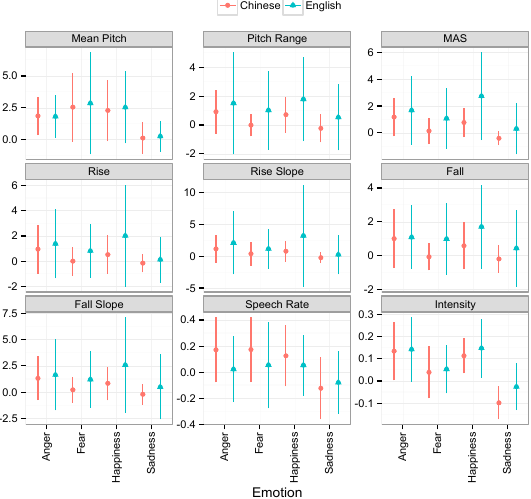
Figure 3. Prosodic cues of four emotions in Mandarin and English. Points indicate mean values and error bars 95% confidence intervals (Adapted from Figure 1 in Reference [31]).